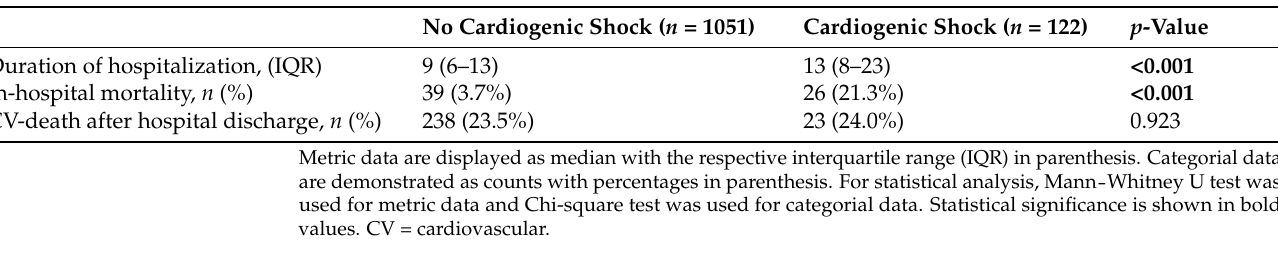
Table 3. Results were plotted in Kaplan – Meier survival curves and confirmed via log-rank